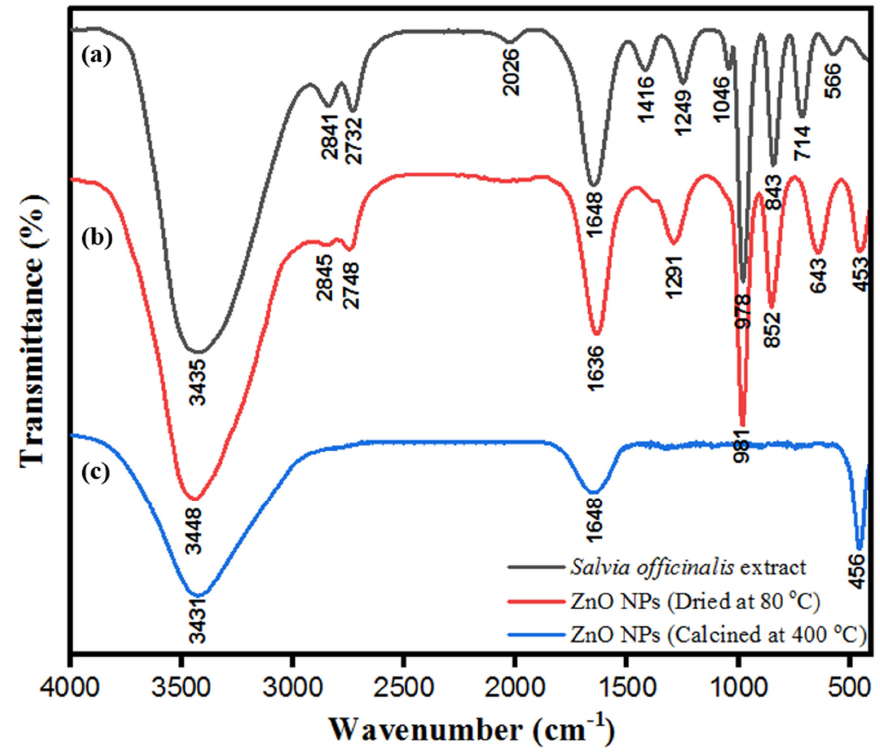
Figure 7. FT ‐ IR spectra of ( a ) aqueous leaf extract of S. officinalis , ( b ) ZnONPs dried at 80 °C, and ( c ) ZnONPs calcinated at 400 °C. Table 1. Spectral positions of FTIR peaks and corresponding mode assignments of S. officinalis aqueous leaf extract and stabilization of ZnONPs by S. officinalis extract.